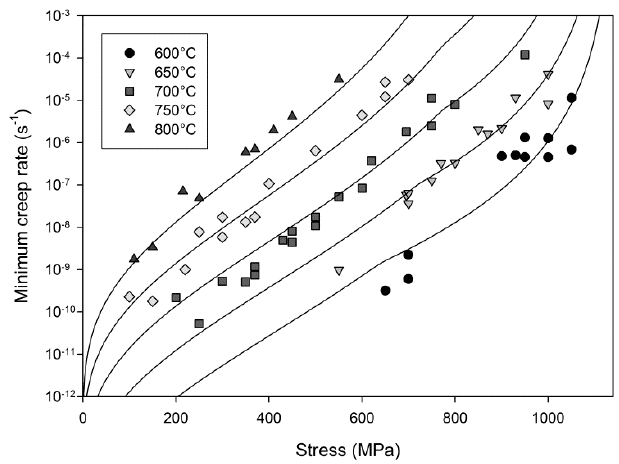
Figure 8. Predictions of minimum creep rate as a function of stress.